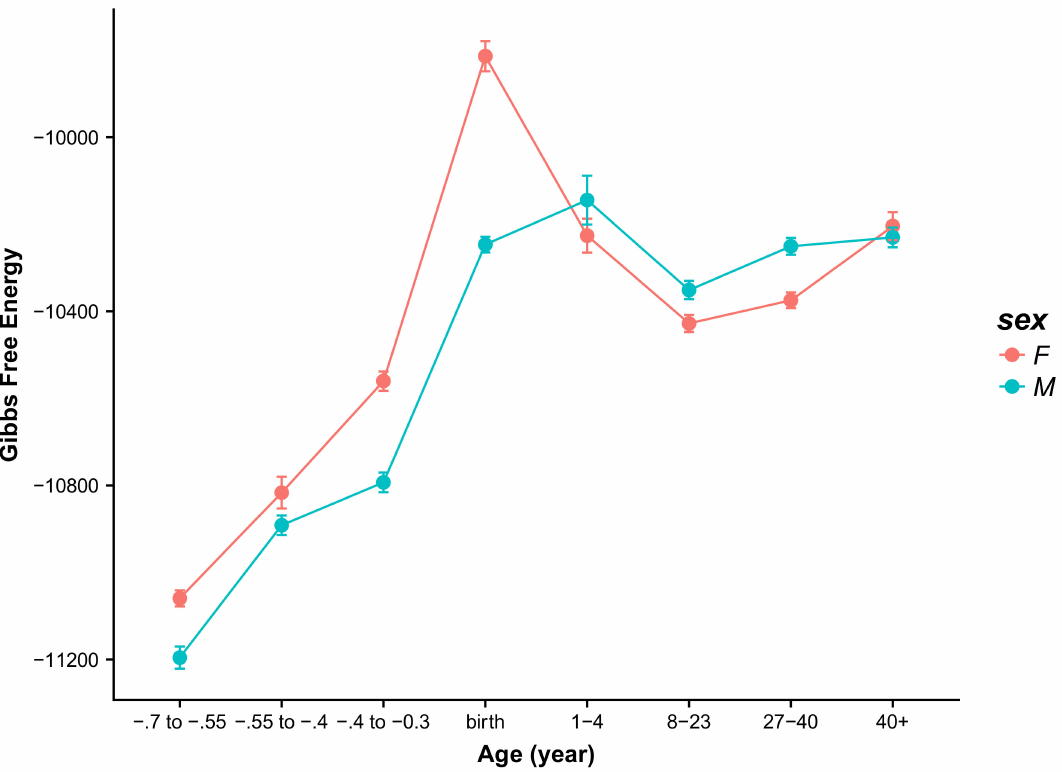
Figure 4. Plot of the Gibbs free energy values averaged over all 16 brain areas and presented for female and male cases